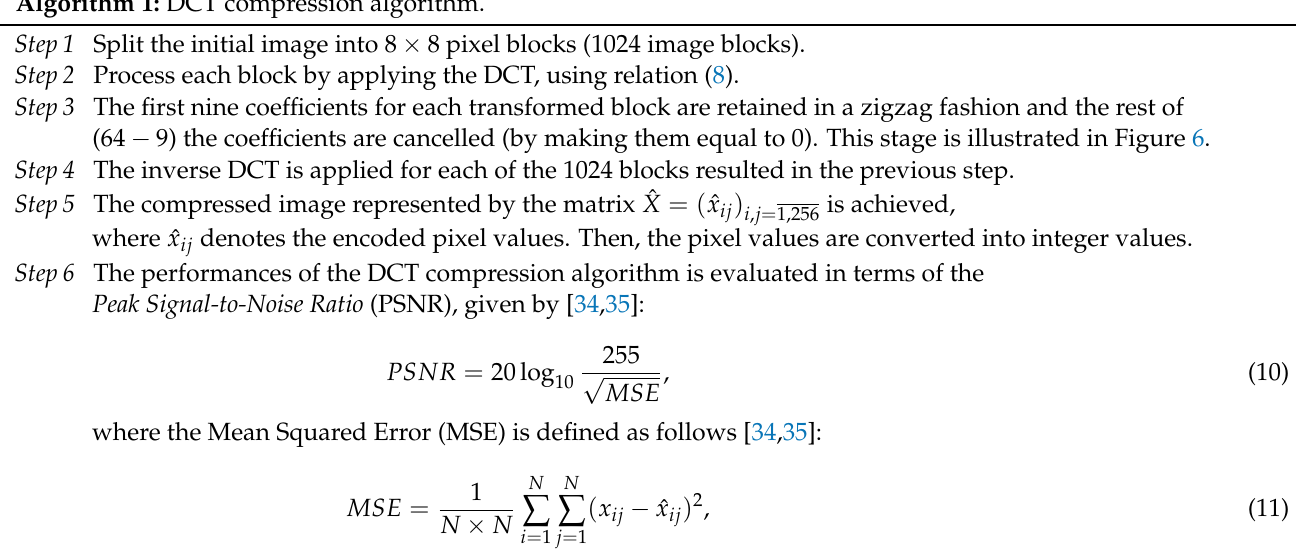
Algorithm 1: DCT compression algorithm.